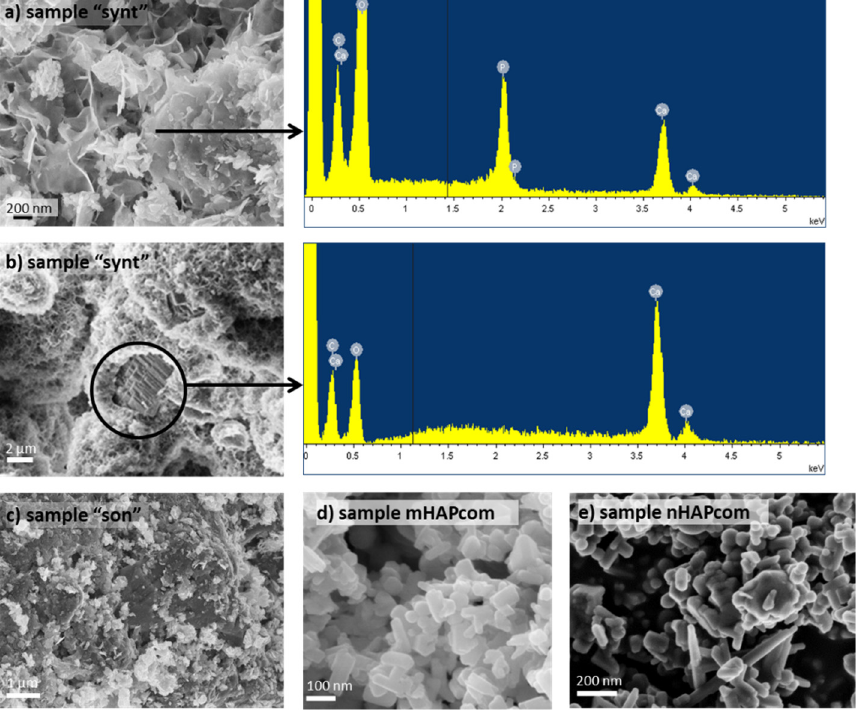
Figure 2. SEM images of the “synt” sample ( a , b ), “son” sample ( c ), mHAPcom ( d ) and nHAPcom ( e ).